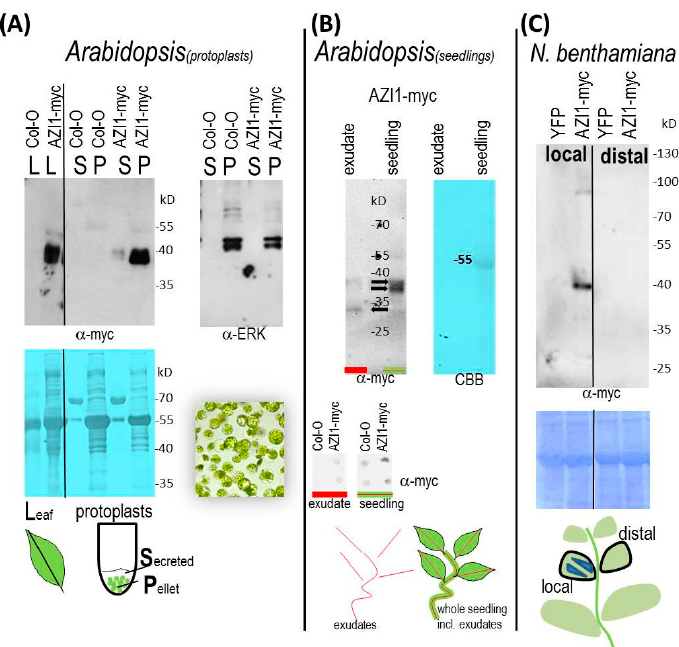
Figure 4. AZI1 secretion and mobility. ( A ) AZI1 secreted from protoplasts. Immunoblot detection of AZI1-myc protein in Arabidopsis leaves (L), extracts from settled mesophyll protoplasts (P) and secreted fluids collected after two days (S). Protoplasts were fully intact (light microscopy, bottom right image); and an antibody against cytosolic protein (a-ERK, right) yielded detectable signals only in protoplast extracts, not in secreted fluids. Protein loading was documented by Coomassie brilliant blue (CBB) staining of the PVDF membranes ( bottom ). Note that the abundant bands in secretion fluids (stained with CBB) were derived from BSA that is contained in the protoplast incubation medium; ( B ) Presence of AZI1 in Arabidopsis seedling exudates. Exudates and total protein extracts from 15-day-old seedlings of AZI1 -myc transgenic lines were examined with anti-myc antibody. Immunoreactive bands observed in the immunoblot ( left ) are indicated by arrows. Absence of RuBisCo (Ru) from the exudates was documented by subsequent CBB-staining of the PVDF membrane ( right ). For dot blot analysis ( bottom ), exudates and seedling total protein extracts were derived from control Col-0 and AZI1 -myc transgenic lines. Experiments were repeated twice; ( C ) Long-distance movement in vivo: N. benthamiana leaves were infiltrated with agrobacteria carrying the YFP (control) or AZI1-myc transgene. Upon subsequent immunoblot analysis with anti-myc antibody AZI1 was detectable in protein extracts from the infiltrated area (marked in blue, bottom image), but not in distal leaves. The relative position of leaves used in these experiments is indicated (border line, bottom image).